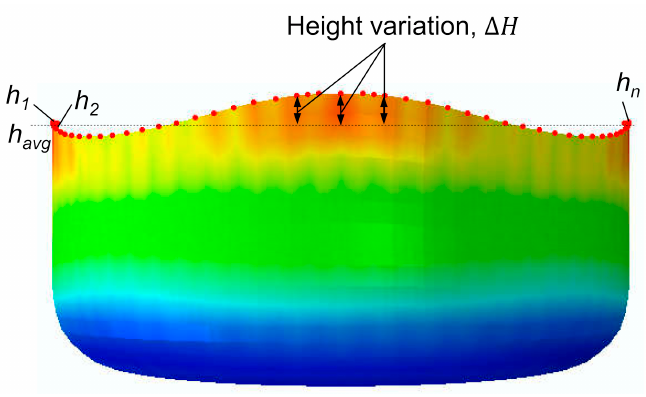
Figure 5. Calculation of earing height variation, ∆ H, to assess the reduction in earing with vary- ing